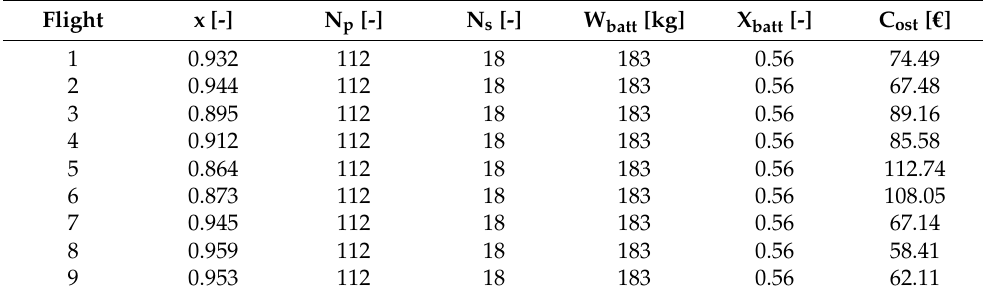
Table 5. Data on training flights used in serial hybrid system calculations. Source: Authors.